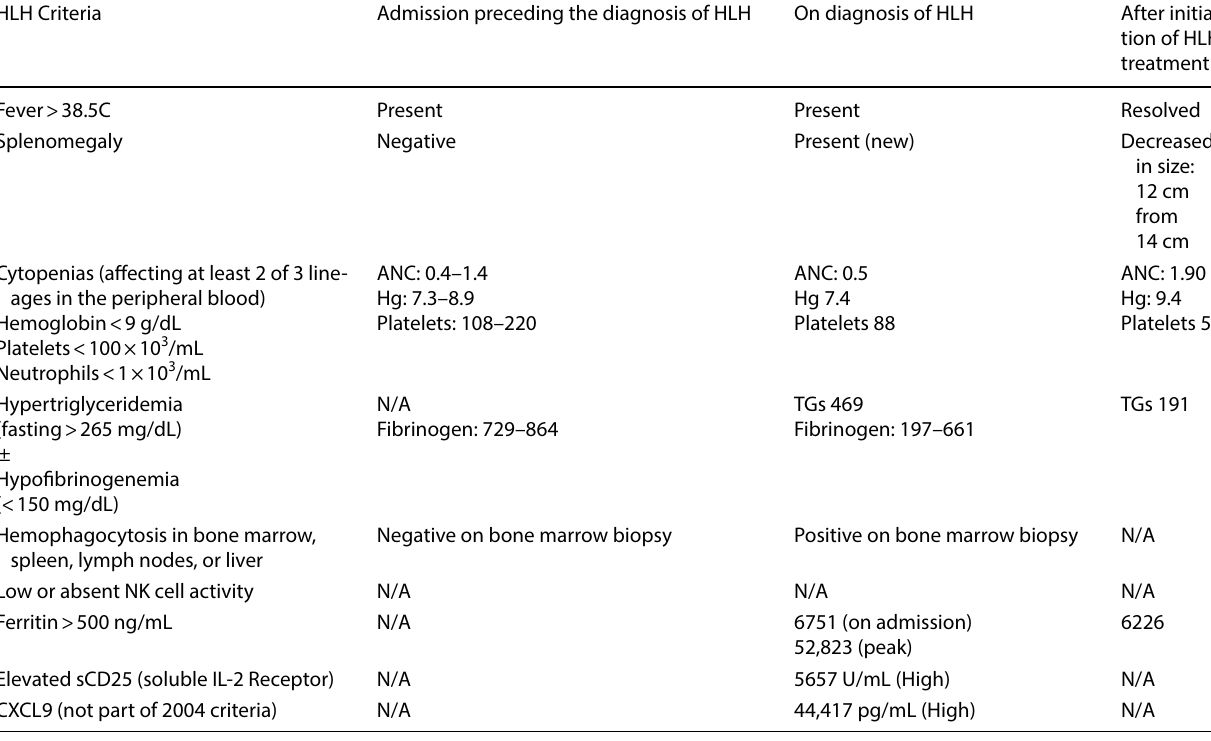
Table 1 Diagnostic evaluation of the patient based on 2004 HLH criteria